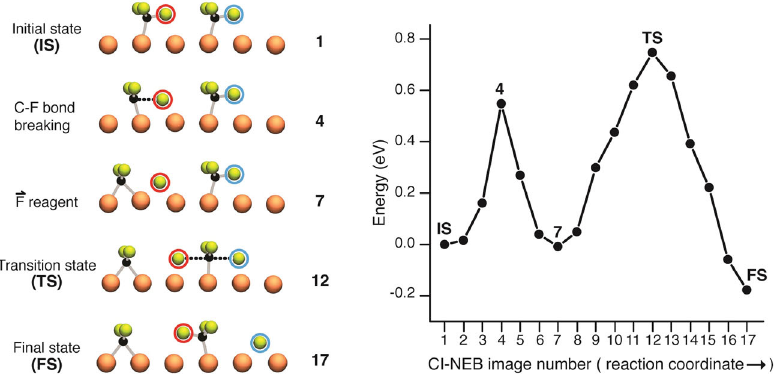
Fig. 4 Climbing image-nudged elastic band (CI-NEB) pathway for knock-on reaction. Minimum-energy pathway across a DFT potential energy surface as obtained from a CI-NEB calculation. Five representative CI-NEB images along the pathway are shown at the left of the fi gure. In the initial state, IS, the CF 3 precursor is at the left and the CF 3 target is at the right. The F-atom, originating in the CF 3 precursor, is marked by a red circle, whereas the (F) ′ product is marked by a blue